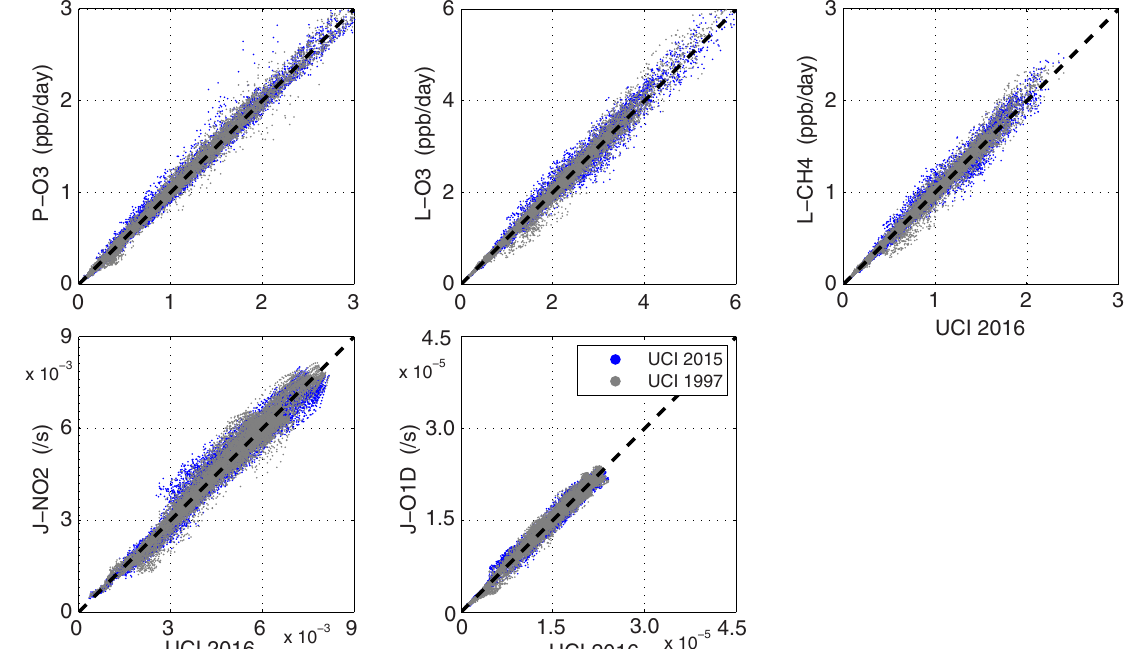
Figure 8. Scatter plot of reactivities and J -values for 5d-mean air parcels for UCI alternate meteorological years (2015, 1997) against the standard year